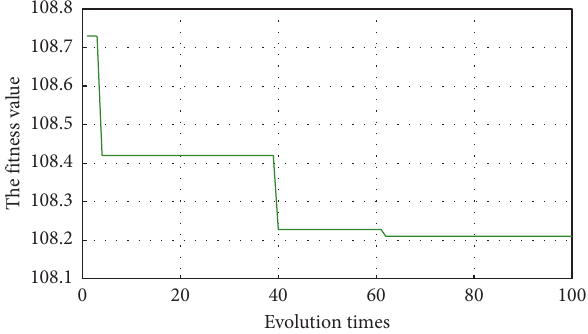
Figure 4: Optimal fitness value